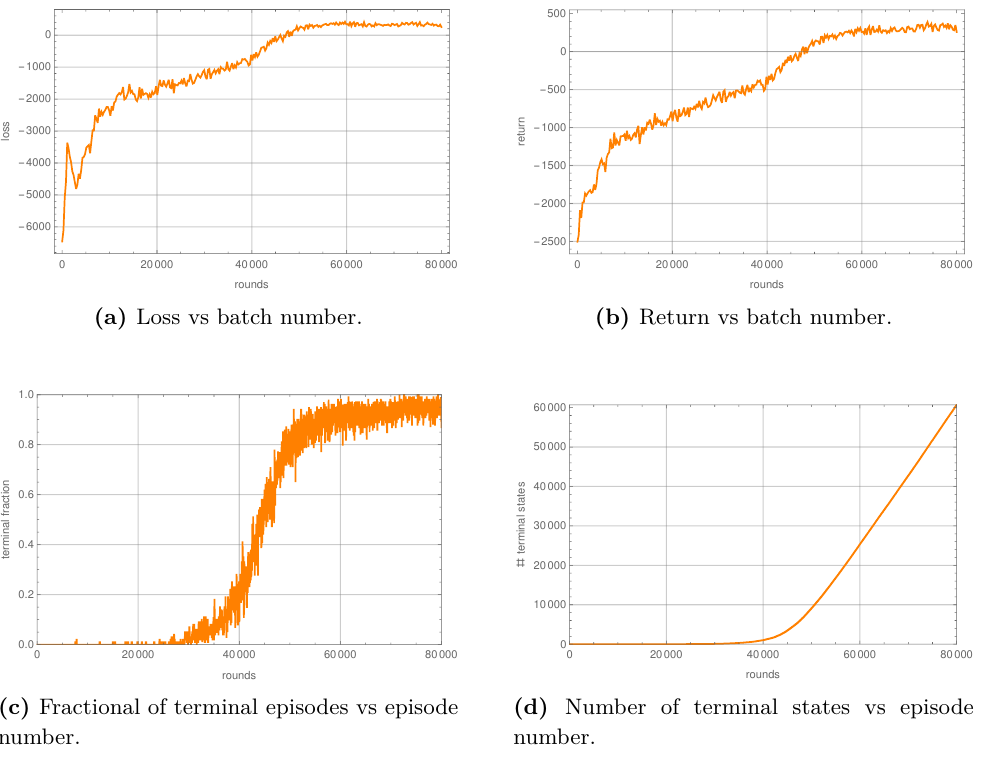
Figure 4. Training measurements for the case of a two U(1) symmetries and − q min = q max = 5